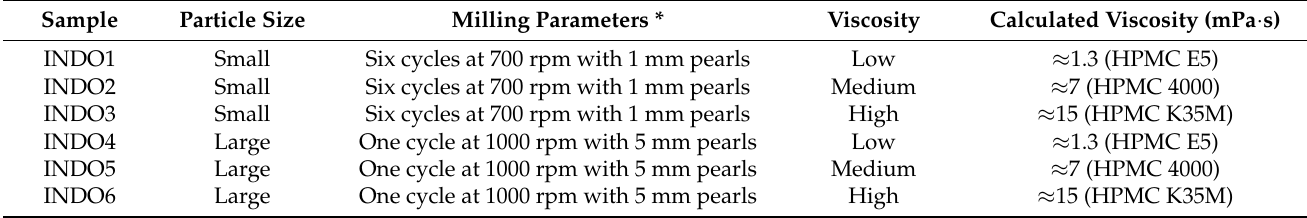
Table 1. Preparation conditions for indomethacin formulations.